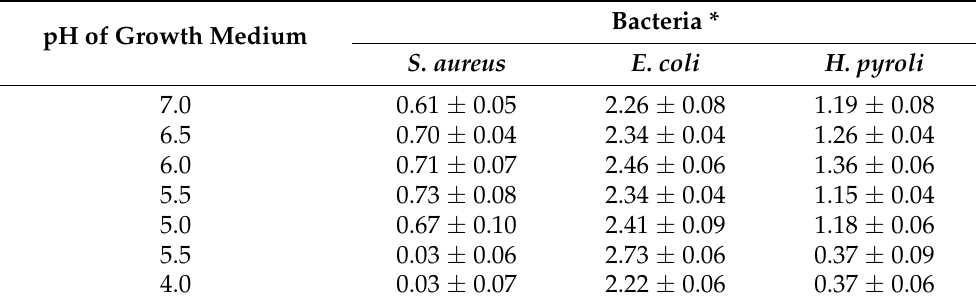
Table 2. Growth of S. aureus, E. coli and H. pylori in media with different pH levels. pH of Growth Medium